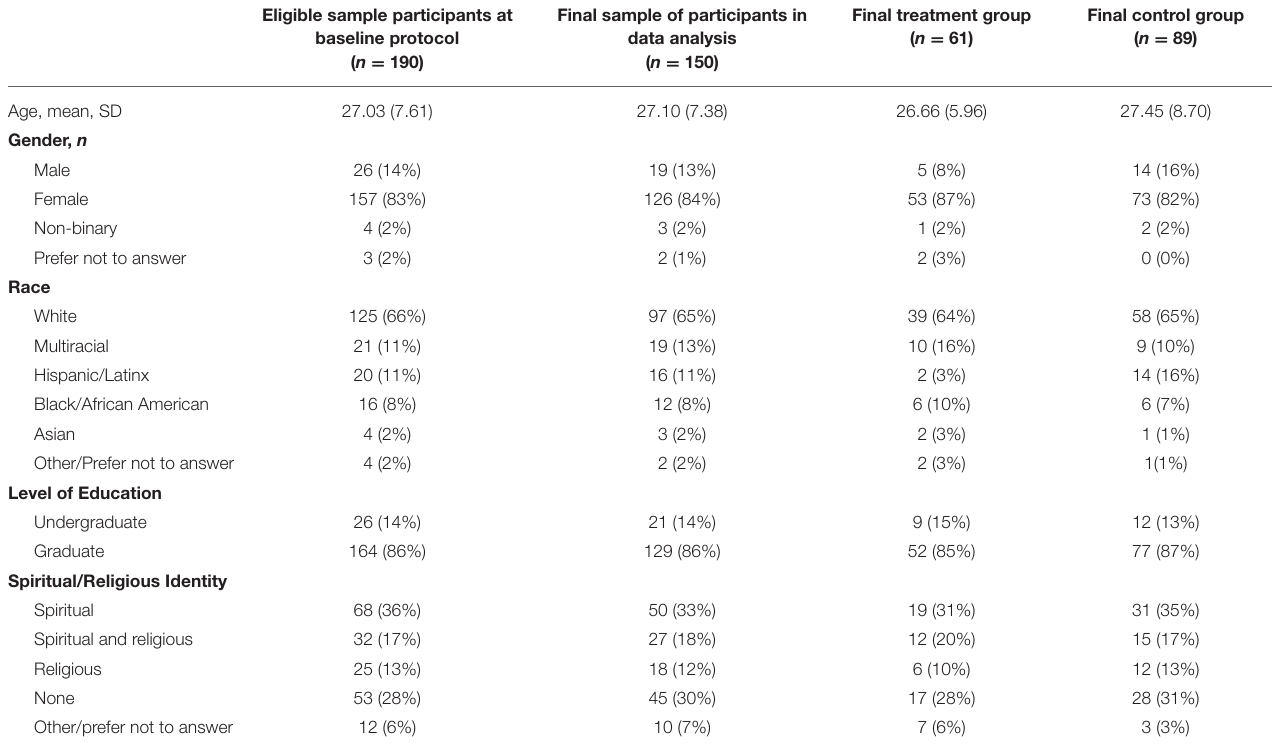
TABLE 1 | Summary of participant descriptive statistics.